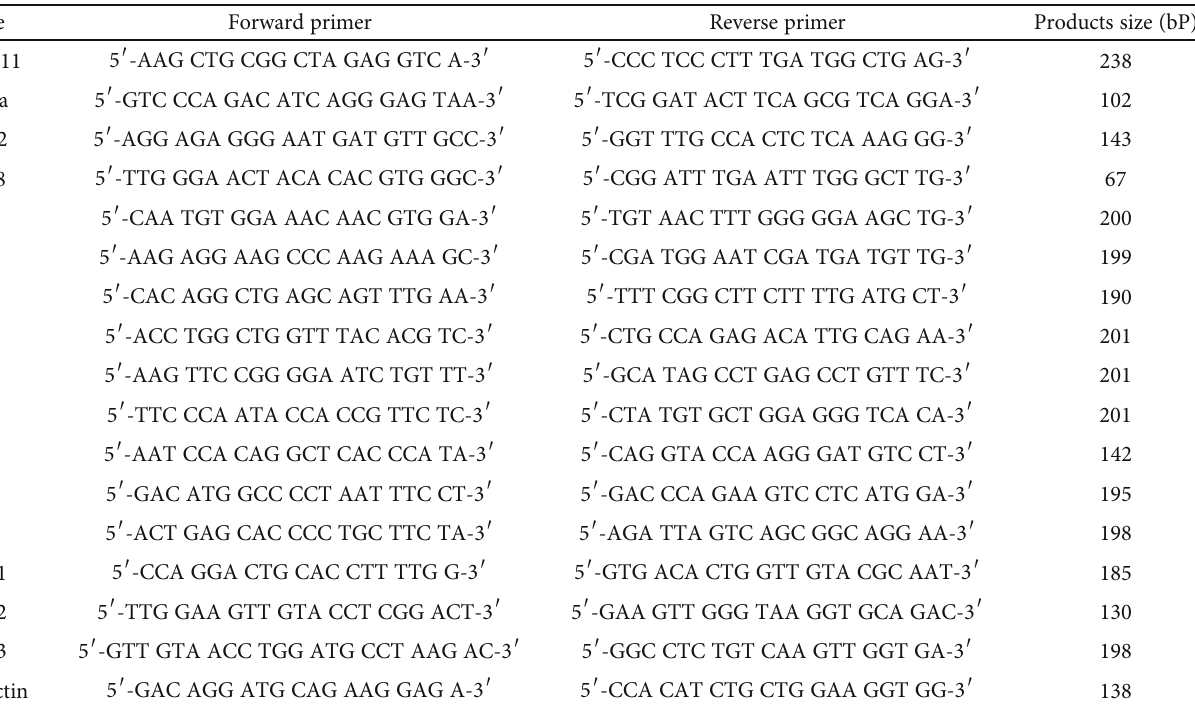
Table 1: The primer has been used for real-time